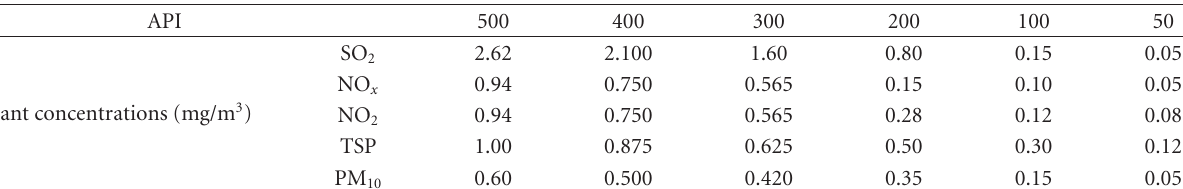
Table 2: Standard air pollutant concentrations and indices.